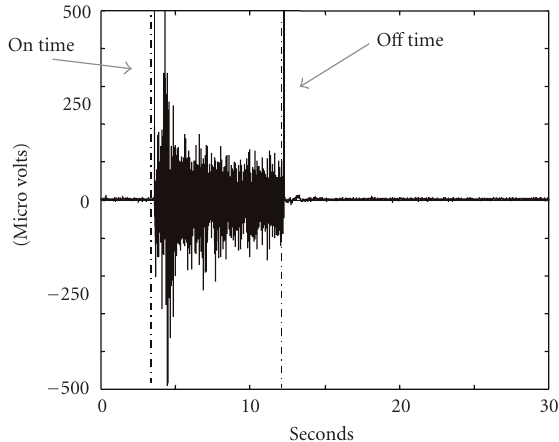
Figure 1: Raw EMG signal with calculated muscle on and o ff times